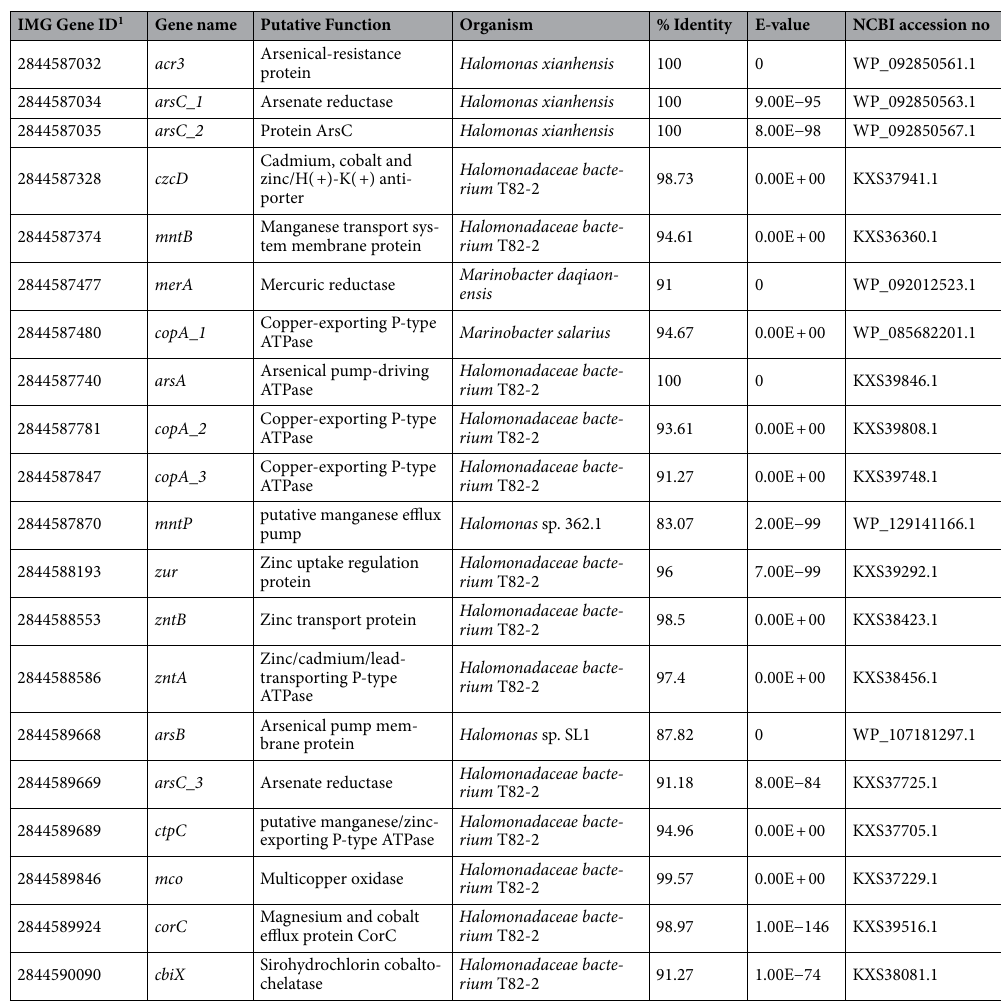
Table 2. Putative functions and top homologs of Modicisalibacter sp. strain Wilcox genes predicted to encode proteins involved in heavy metal resistance. 1 Gene sequences were BLAST p searched against NCBI nr database in NCBI for top